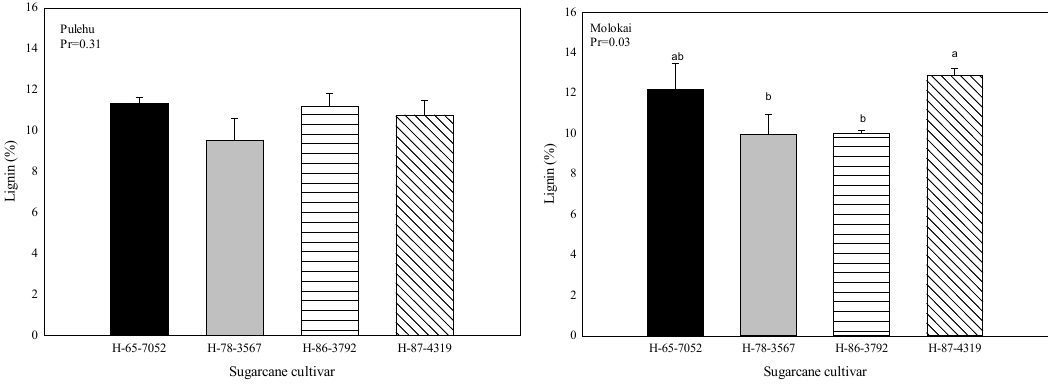
Figure 8. Lignin content (%) from sugarcane cultivars plant samples collected less than two weeks prior to harvest date. Means from sugarcane cultivars bars followed by the same letter or no letters are not significantly different Tukey’s test at Pr <